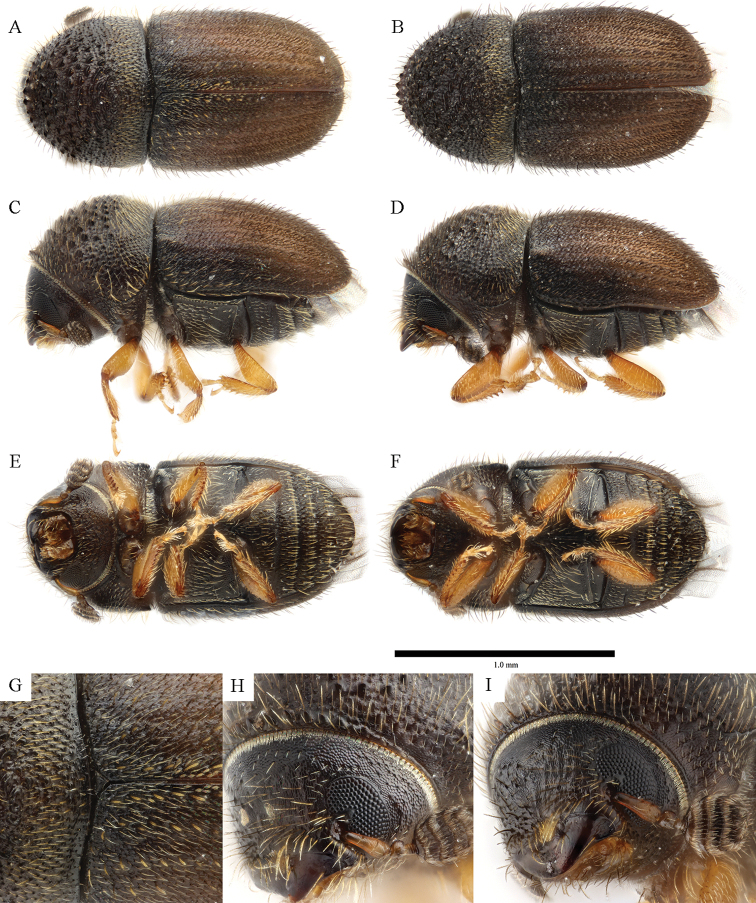
Cryphalus
gnetivorusA, C, E, G, H holotype, female, UFFE:31751 B, D, F, I paratype, male, UFFE:31753.